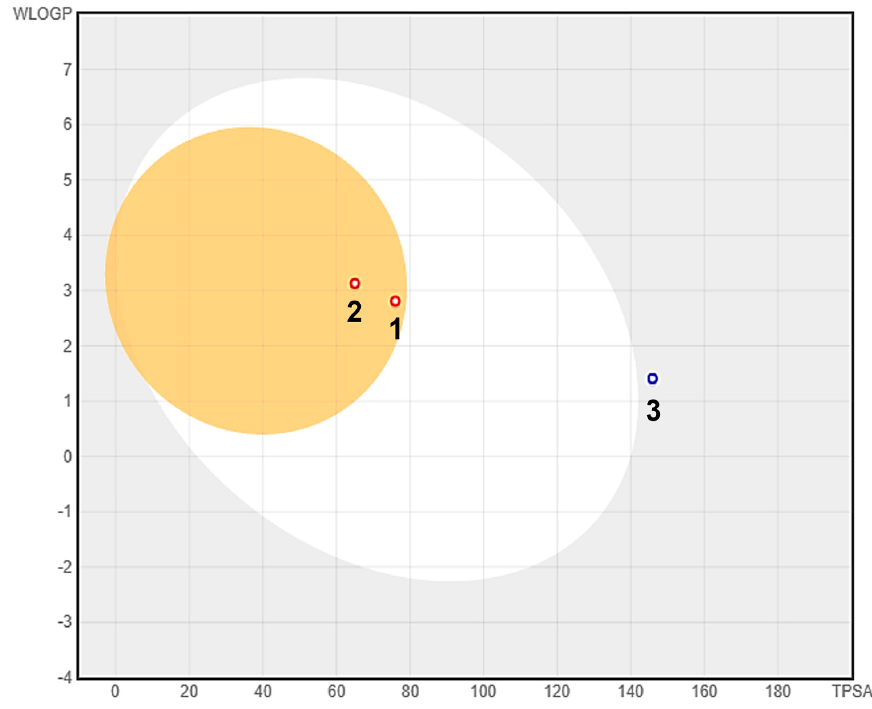
Figure 6. Prediction of GI tract and brain permeation of compounds 1 - 3 by brain or the intestinal estimated permeation predictive model (BOILED-Egg) method.